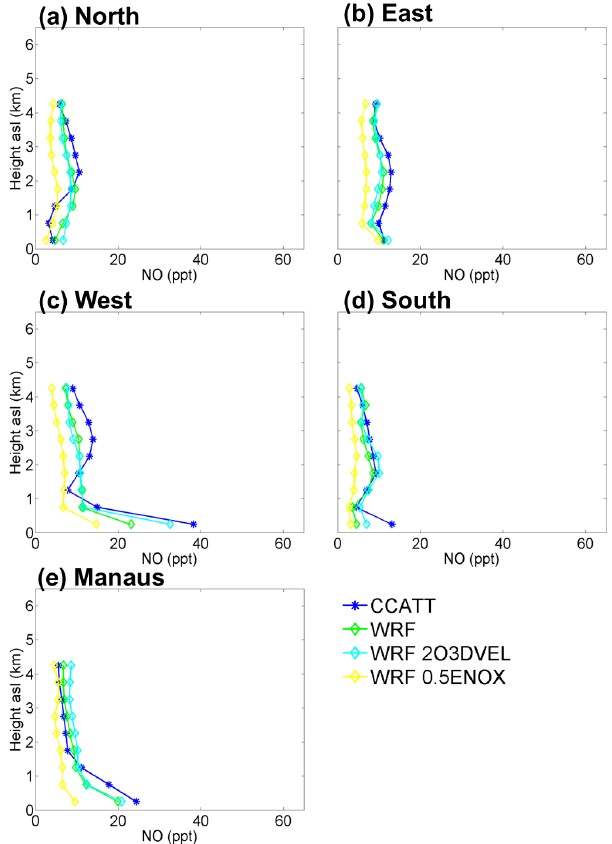
Figure 15. Mean vertical NO profiles corresponding to BARCA B flights for CCATT-BRAMS (blue) and WRF-Chem (base case: green, 2DEPVEL: cyan, and 0.5ENOx: yellow) simulations by re- gion: (a) north, (b) east, (c) west, (d) south, and (e) around Manaus.